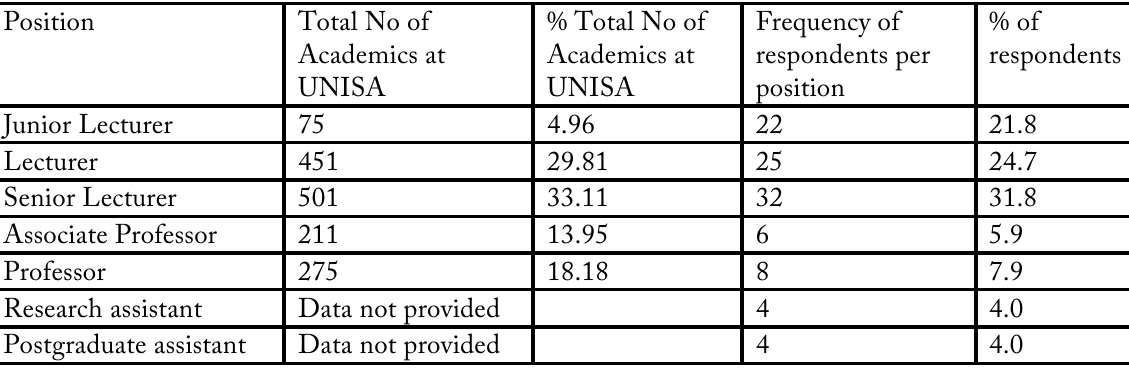
Table 3: Distribution of academics at UNISA and the respondents’ positions of employment Position